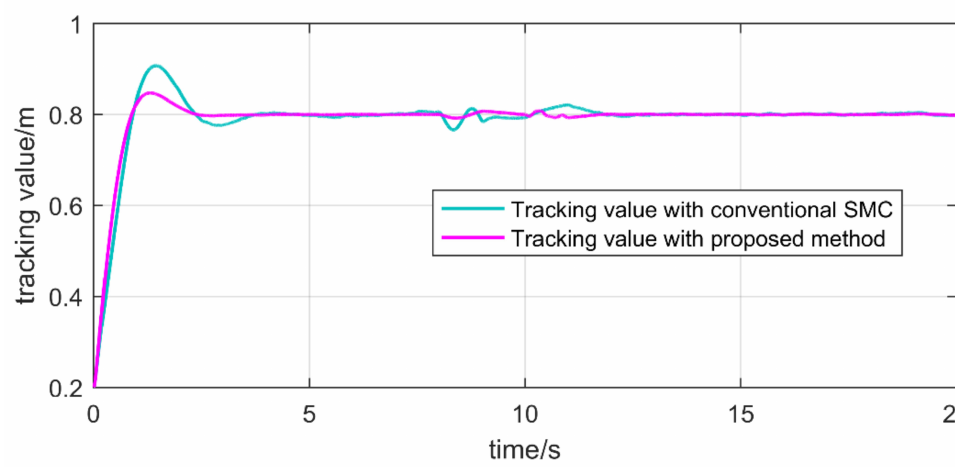
Figure 9. Trajectory tracking of position y